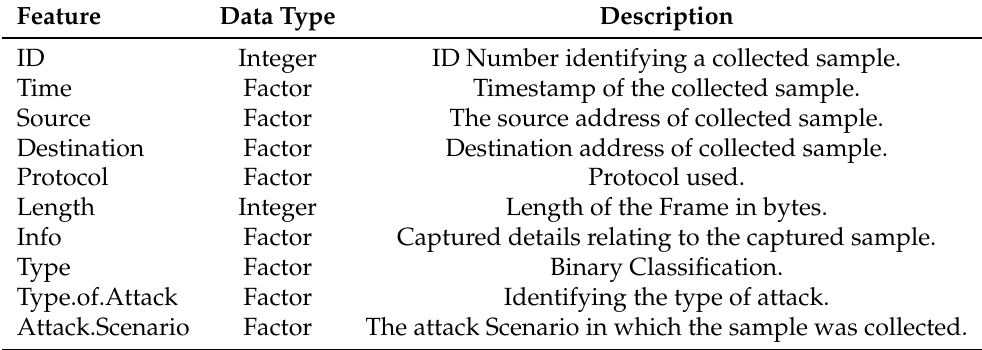
Table 3. ECU-IoFT dataset structure.